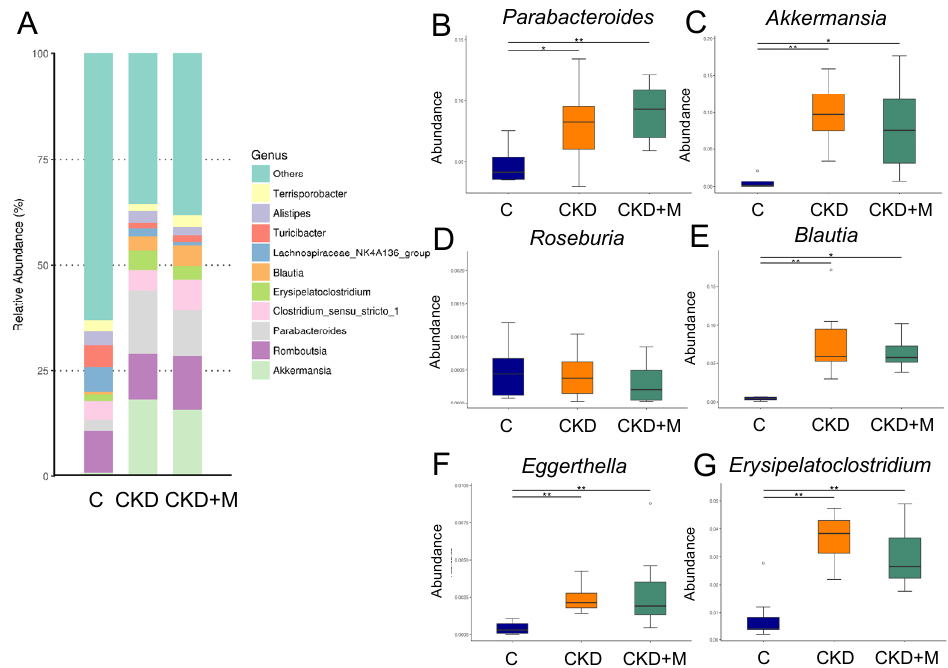
Figure 4. Gut microbiota at the genus level in female rats. ( A ) The relative abundance of the top 10 genera of the gut microbiota among the three groups. The abundance of genera ( B ) Parabacteroides , ( C ) Akkermansia , ( D ) Roseburia , ( E ) Blautia , ( F ) Eggerthella , and ( G ) Erysipelatoclostridium among the three groups. N = 8/group. Data are shown as means ± SD. The single asterisk indicates p < 0.05 vs. C. The double asterisk indicates p < 0.01 vs. C.